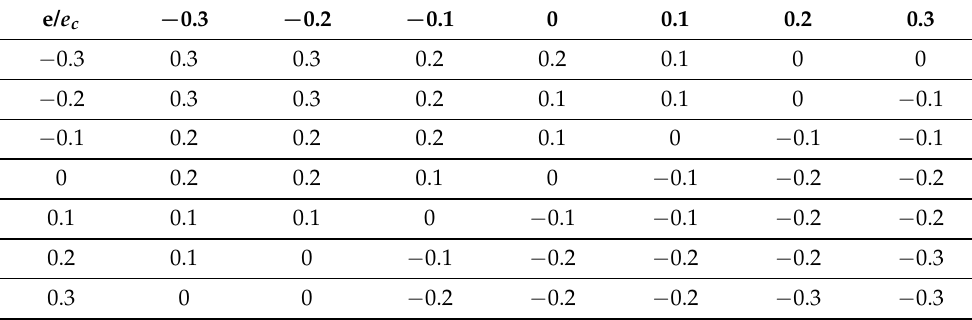
Table 3. K p seven-valued function.